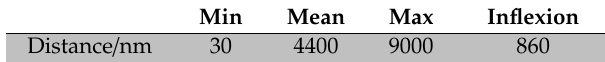
Figure 4a; Spreadsheet S3: distance of capillary pores from the surface of the anhydrous C 3 S particle in Figure 6a.